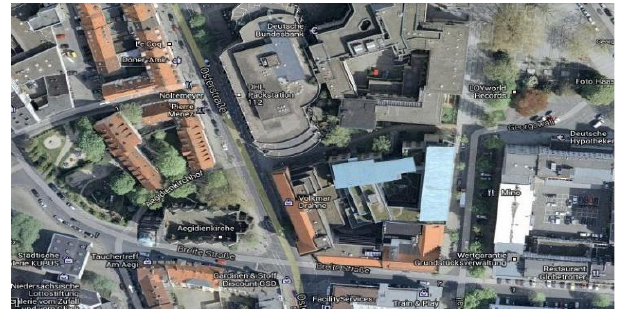
Figure 1: A google image of the urban scene taken as study area